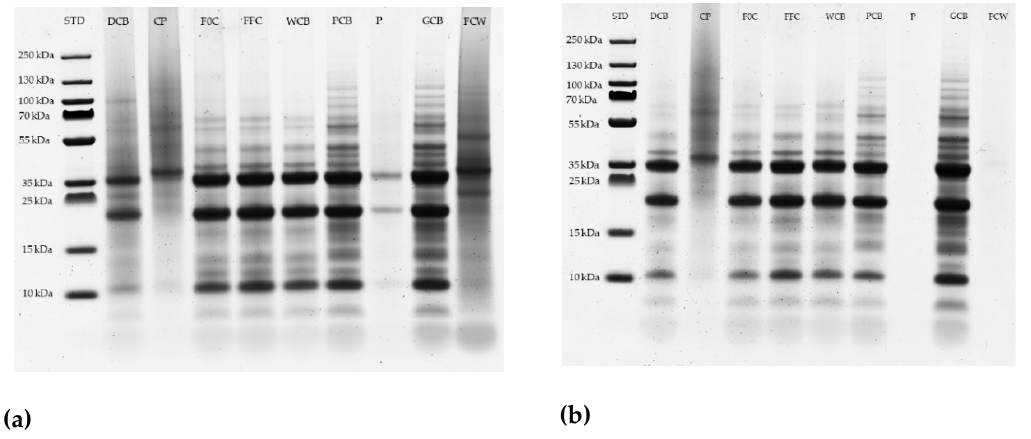
Figure 6. Electrophoresis of co ff ee beans, by-products and wastewater samples. ( a ) Batch and ( b ) continuous processing. With STD the protein ladder, DCB the de-pulped co ff ee beans, CP the co ff ee pulp, F0C the initial fermentation co ff ee beans, FFC the final fermentation co ff ee beans, WCB the washed co ff ee beans, PCB the parchment co ff ee beans, P the parchment, GCB the green co ff ee and FCW the fermented